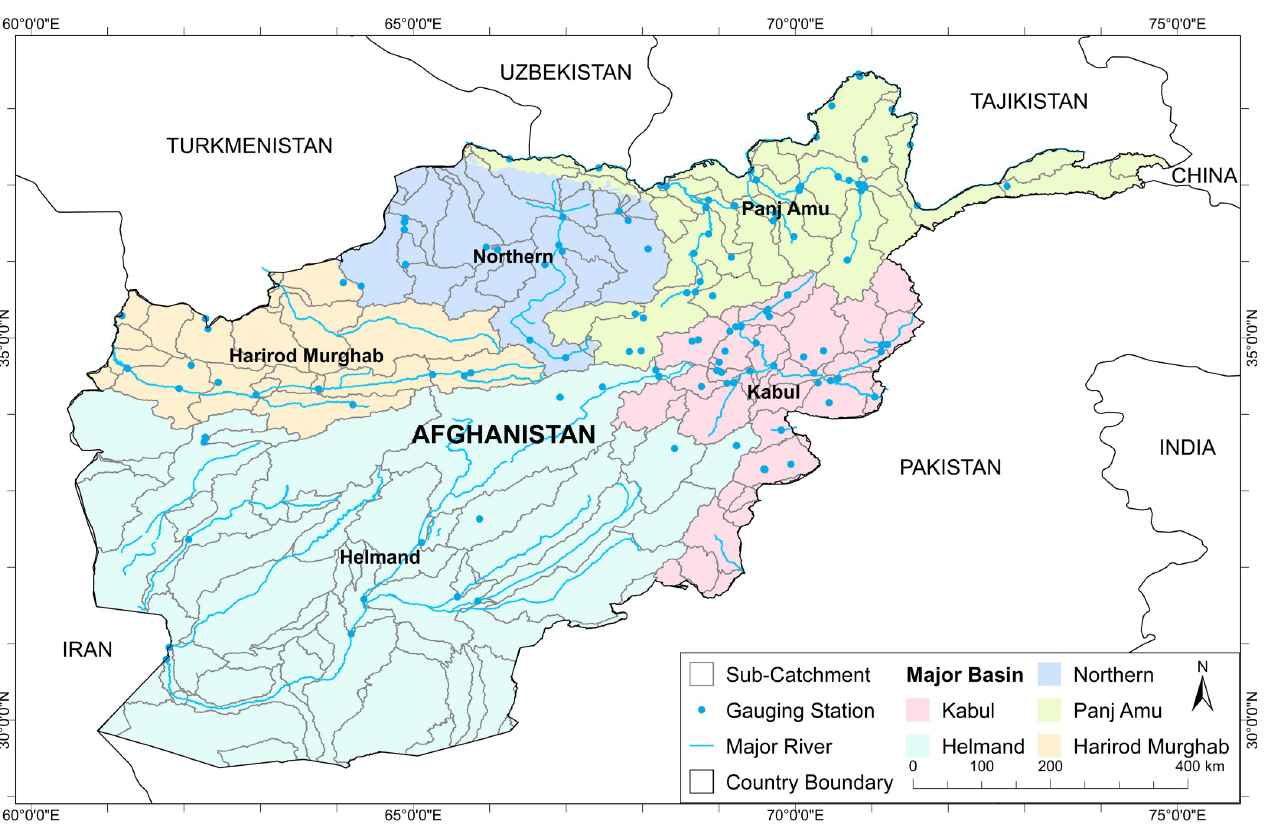
Fig 1. Location map of